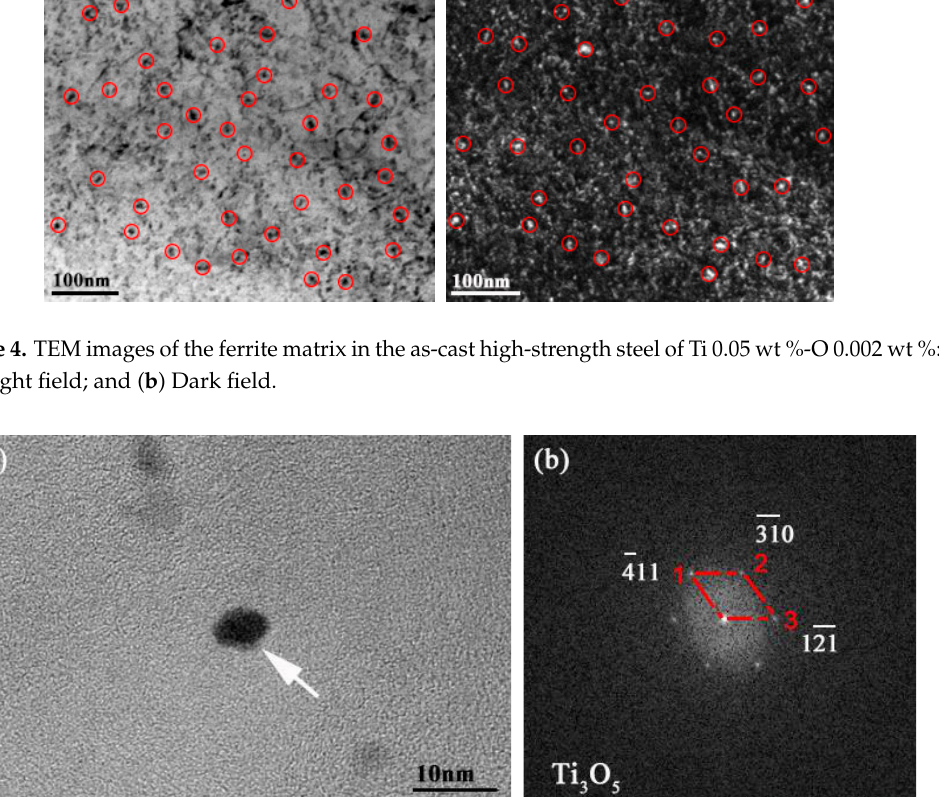
Figure 5. ( a ) HRTEM image of dispersed nanoparticles in high-strength steel; and ( b ) the corresponding FFT pattern of the black nanoparticles marked by white arrow in ( a ).